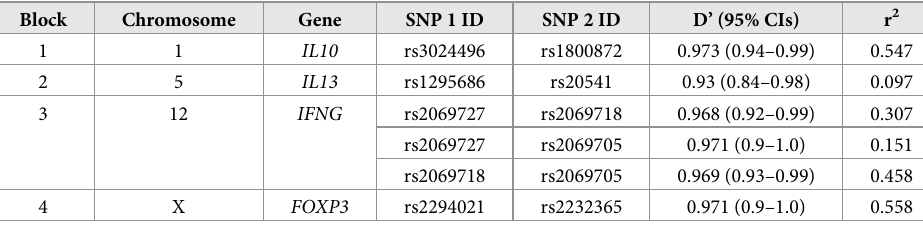
Table 2. Linkage disequilibrium statistics of haplotype